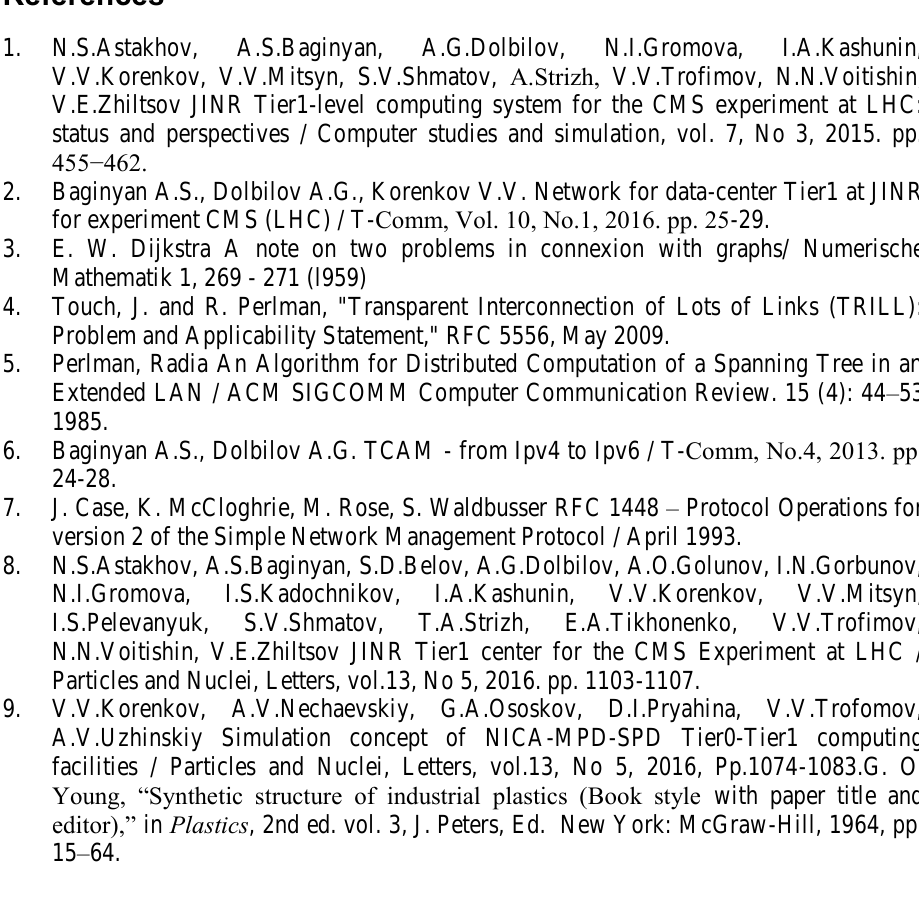
Fig. 7. Incoming/outgoing traffic of TenGigabit 013-016 network